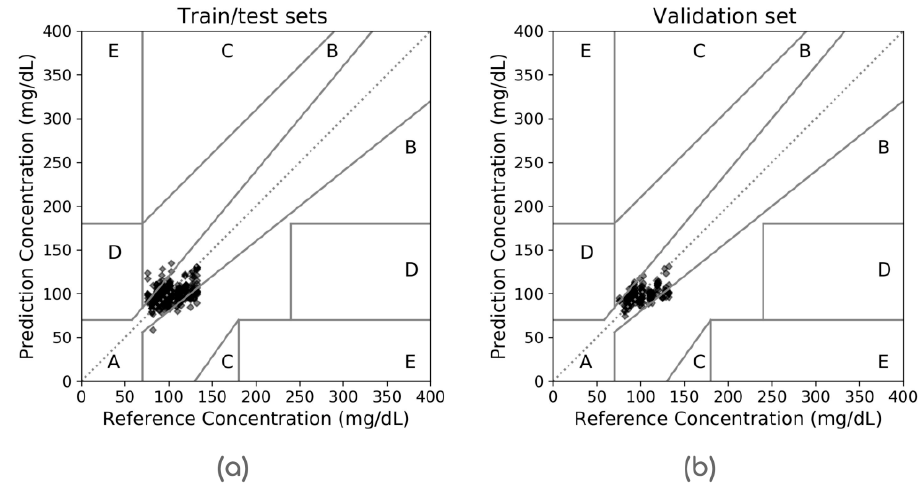
9 of 13 Figure 7. Example of mobile application screens ( a ) for login and ( b ) current glucose level. 3.3. Model Selection and Validation To obtain reliable results regarding the implementation of the ANN model, the input dataset was split into train/test (70%) and external validation (30%) subsets. In the first subset–the train/test split–a 10-fold cross validation scheme was performed. The ANN model was trained using the parameters and configuration determined in the model validation, considering the MAE and the Clarke grid error analysis as the evaluation metrics. For details of the latter, please refer to Section 2.5.1. The dataset was first divided into train/test subsets to conduct the 10-fold cross-validation process, resulting in an 11.81 mg/dL mean absolute error, and a Clarke error grid zone percentage of A = 83.84%, B = 16.16%, and 0% for the rest of zones. The validation subset was then fed to the trained